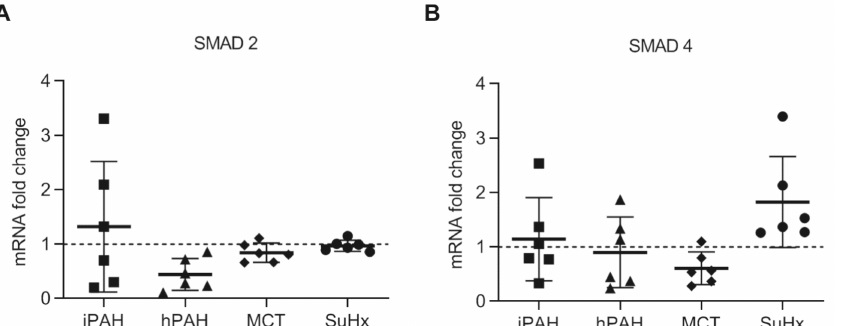
Figure 4. The mRNA expression of SMAD2 and SMAD4 in the whole lung lysate analyzed by qPCR: ( A ) the mRNA expression of SMAD2/3 in human PAH patients and animal PAH models; ( B ) the mRNA expression of SMAD4. n(iPAH) = 6, n(hPAH) = 6, n(MCT) = 6, n(SuHx) = 6. iPAH: idiopathic pulmonary arterial hypertension, hPAH: hereditary pulmonary arterial hypertension, Ctrl: control, MCT: monocrotaline rats, SuHx: sugen–hypoxia rats. The control group of iPAH and hPAH: donors without PAH. The control group of MCT: healthy Wistar rats. The control group of SuHx: healthy Sprague Dawley rats.